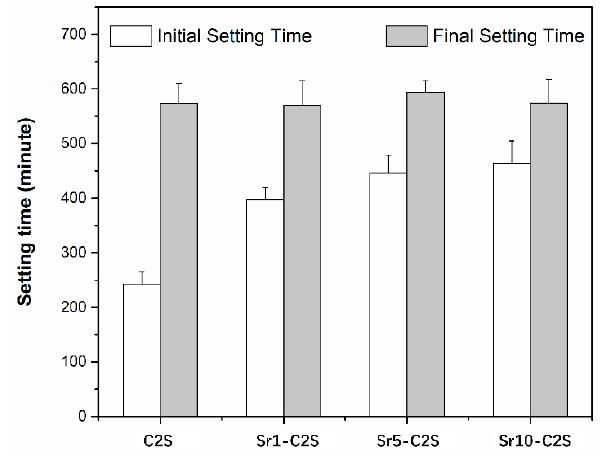
Figure 6. Initial and final setting time of C2S and Sr-C2S bone cement. The initial setting time increases with increasing content of Sr.